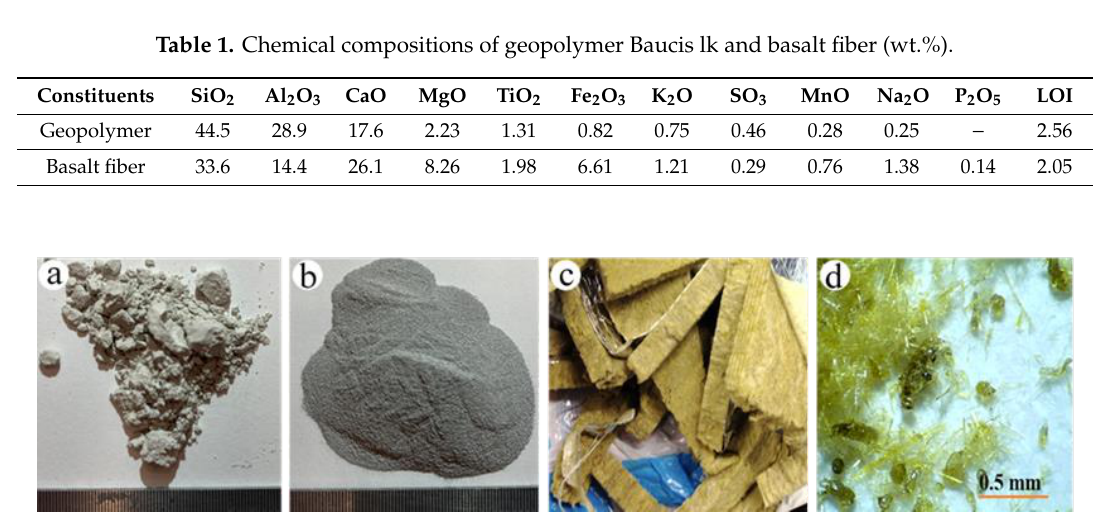
Figure 1. Photographs showing the materials: ( a ) geopolymer Baucis lk, ( b ) aluminum powders, ( c ) basalt fibers before grinding, and ( d ) basalt fibers after grinding.